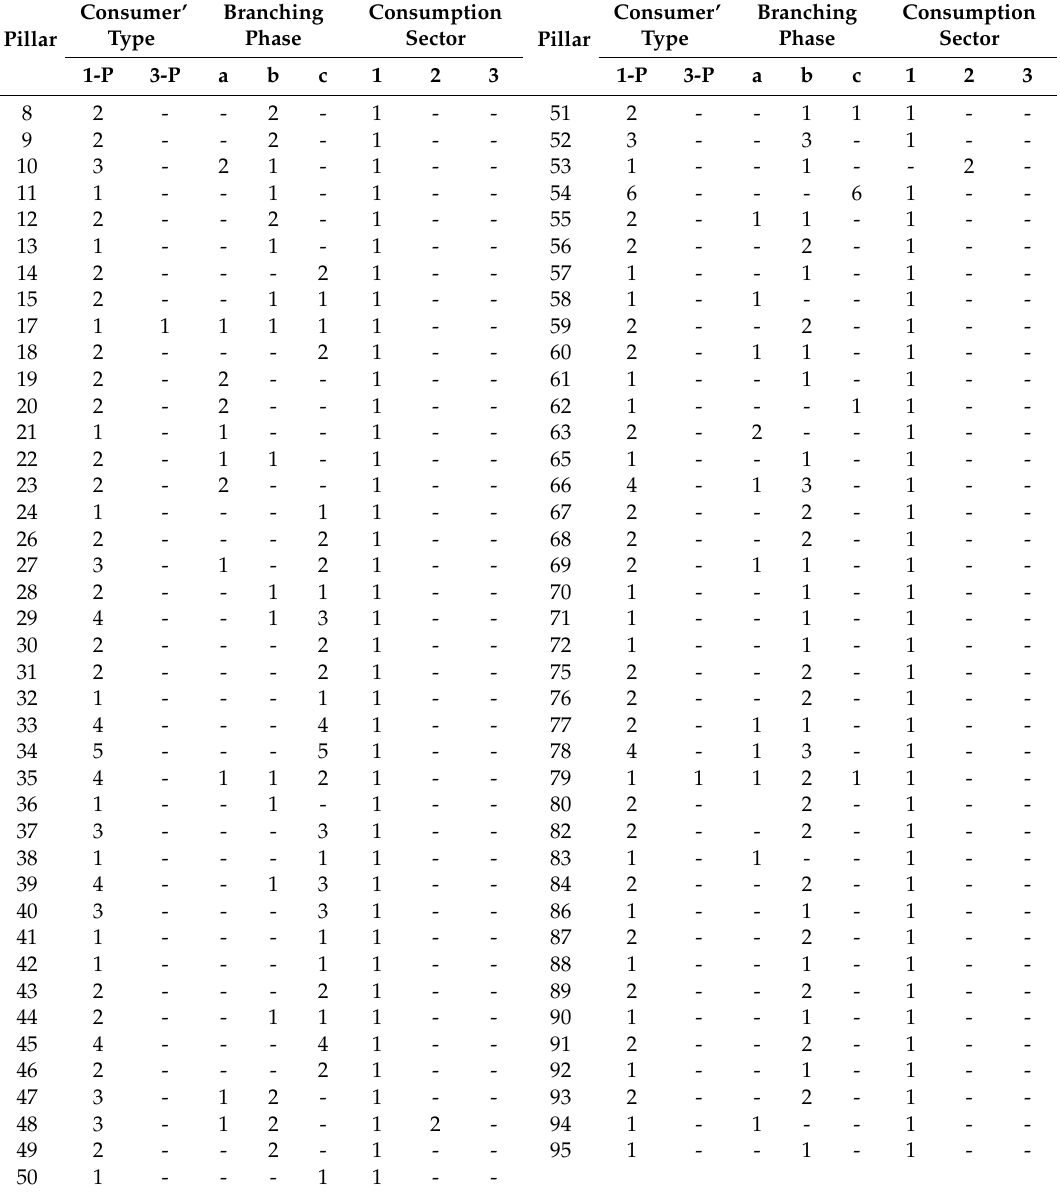
Table A1. The allocation on pillar, phase, and the consumption